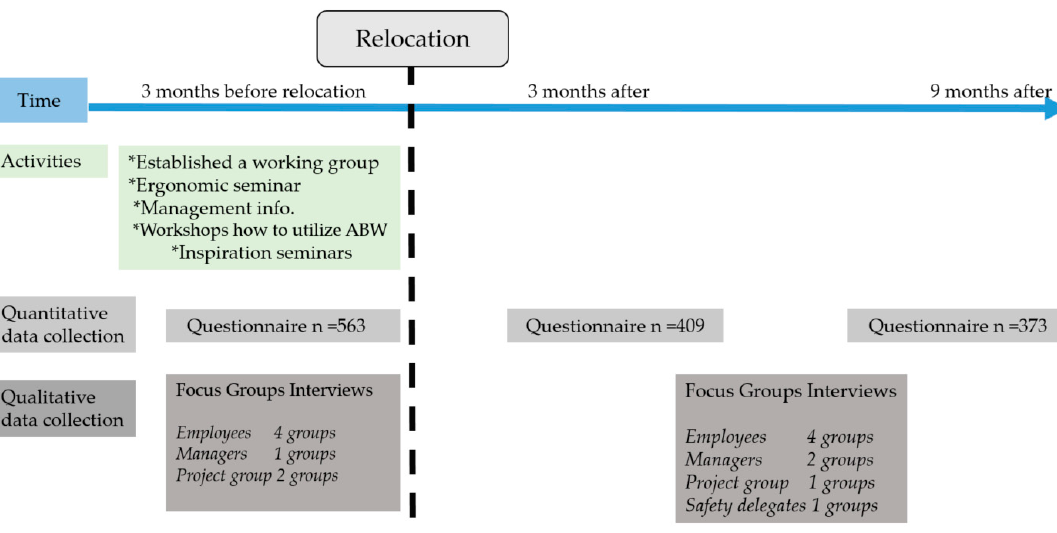
Figure 1. Timeline for implementation and data collection (2018–2019).